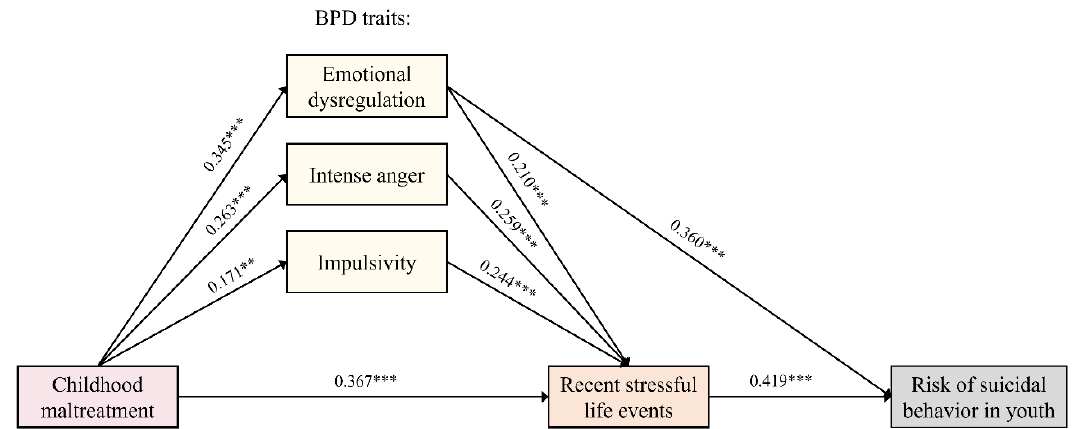
Figure 4. Final model obtained by path analysis. Our results support the hypothesis that youths with a more severe/frequent history of CM present a higher risk to recent SLEs. Furthermore, we found that youths with greater CM exposure had more BPD traits (emotion dysregulation, intense anger and impulsivity), which, in turn, directly predict higher incidence of recent SLEs. Nevertheless, SB was only correlated with emotion dysregulation and recent SLEs, but not with CM or the other BPD traits (impulsivity or intense anger) as we hypothesized. p values: ** p ≤ 0.01, and *** p ≤ 0.001.